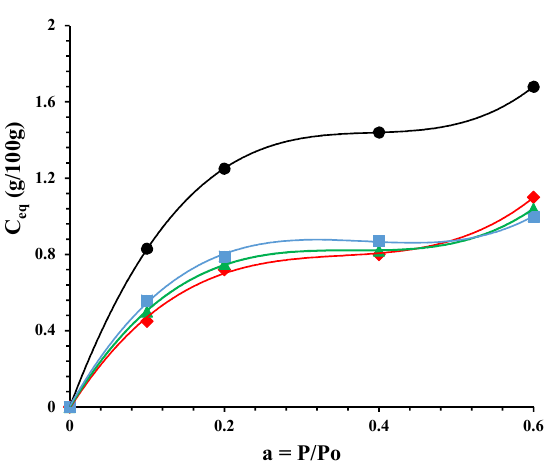
Figure 5. Sorption isotherms for: PCL/10%HNTs-lysozyme ( • ), a sample drawn at λ = 3 ( (cid:7) ), a sample drawn at λ = 4 ( ▲ ), and a sample drawn at λ = 5 ( ■ ).